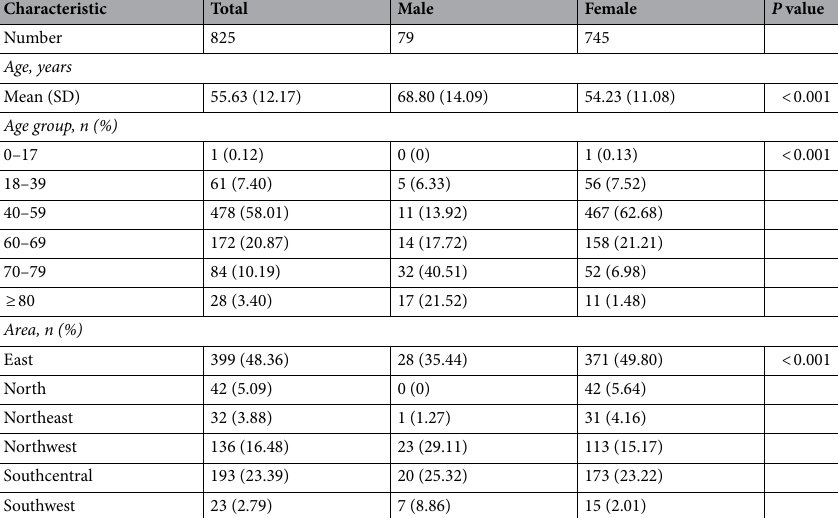
Table 2. Characteristics of patients with mammary Paget’s disease in Chinese 23 provinces in 2016. SD, standard deviation. Note: a total of one patient had missing information in sex and age. East area contains Jiangsu, Zhejiang, Anhui, Jiangxi, and Shandong (five provinces). North area contains Shanxi, Inner Mongolia (two provinces). Northeast contains Liaoning, Jilin, Heilongjiang (three provinces). Northwest contains Shaanxi, Qinghai, Gansu, and Xinjiang (four provinces). Southcentral contains Henan, Hubei, Hunan, Guangdong, Guangxi and Hainan (six provinces). Southwest contains Chongqing, Guizhou and Yunnan (three